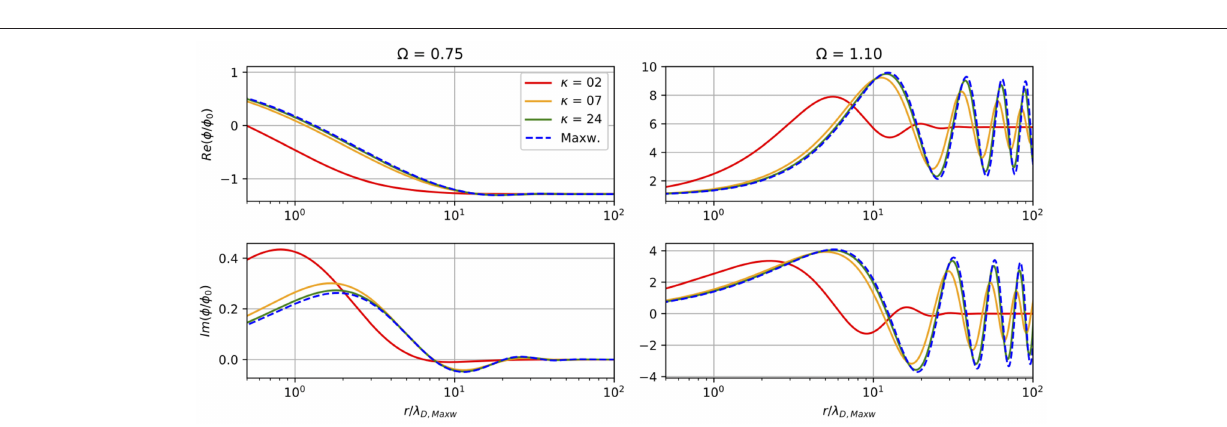
2,7 and 24) in colored continuous lines =